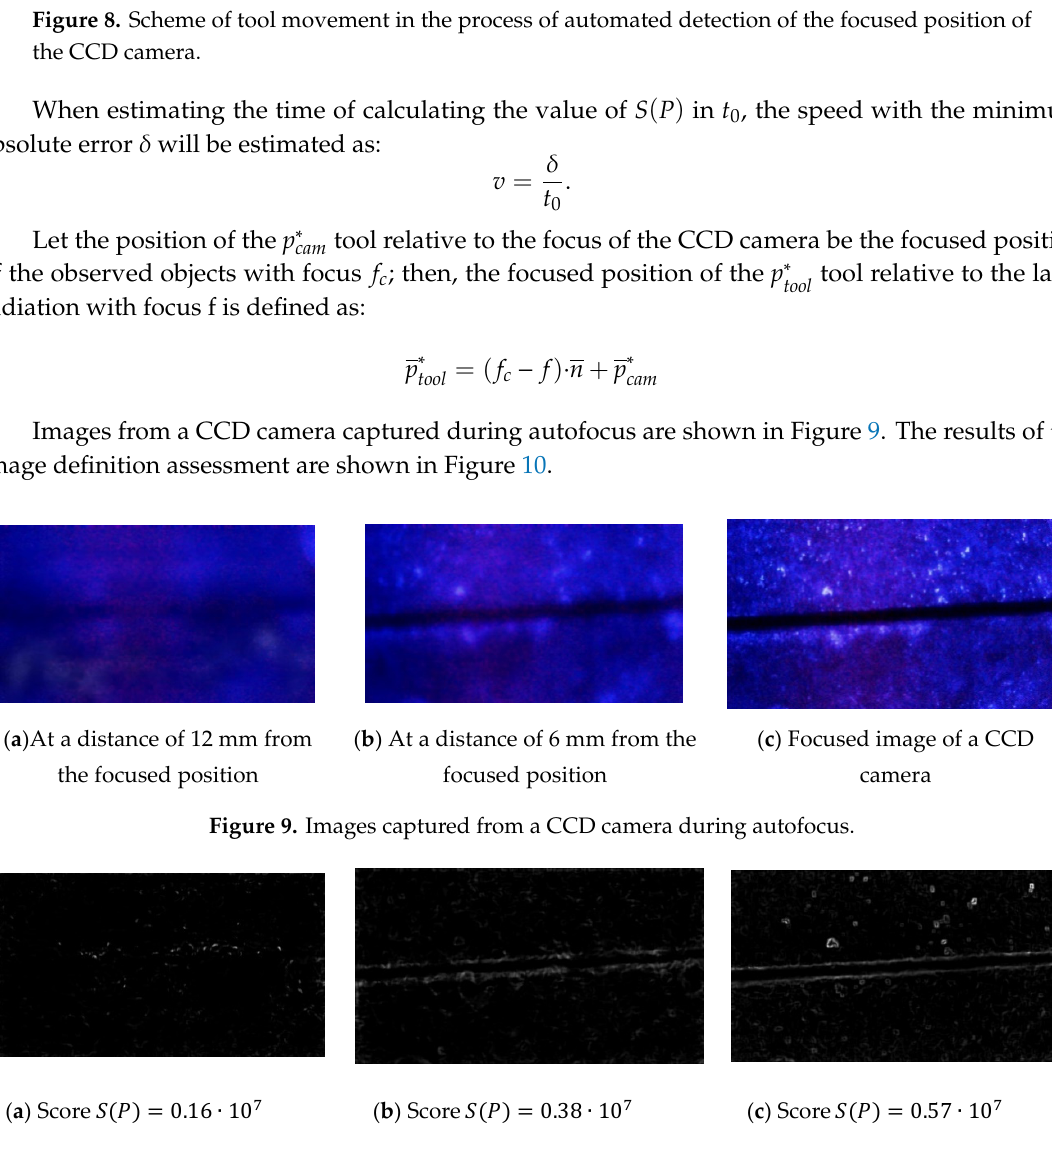
Figure 10. Result of image blur estimation.